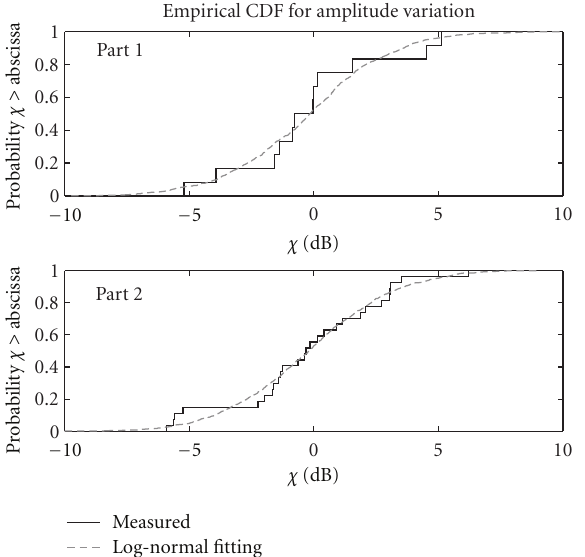
Figure 8: CDFs of the number of paths L for Rx14 (LOS) in the UWB band measurements.